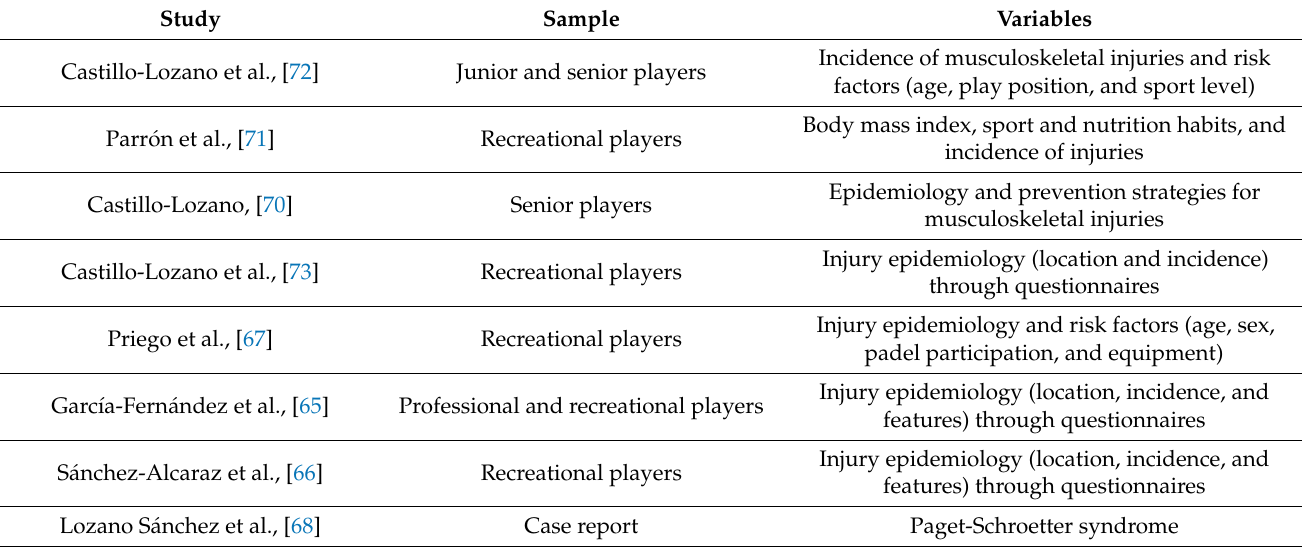
Table 4. Summary of studies exploring injuries of padel